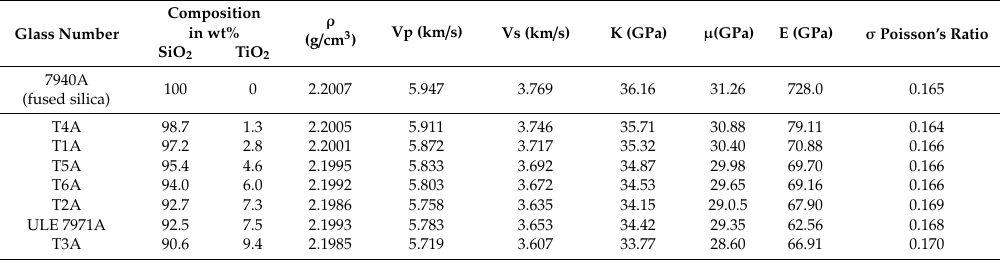
Table 1. Chemical composition and ultrasonic elastic parameters of seven SiO 2 –TiO 2 glasses at an ambient pressure and temperature. The measurements of these glasses after annealing are